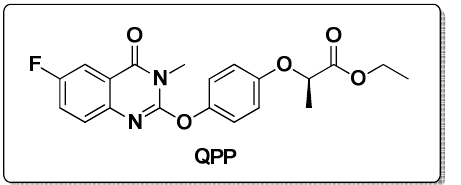
Figure 1. The structure of ACCase-inhibiting herbicide QPP.